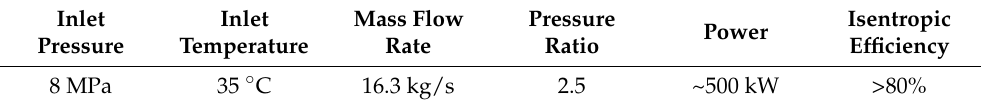
Table 2. Main design parameters of the single-stage centrifugal compressor.